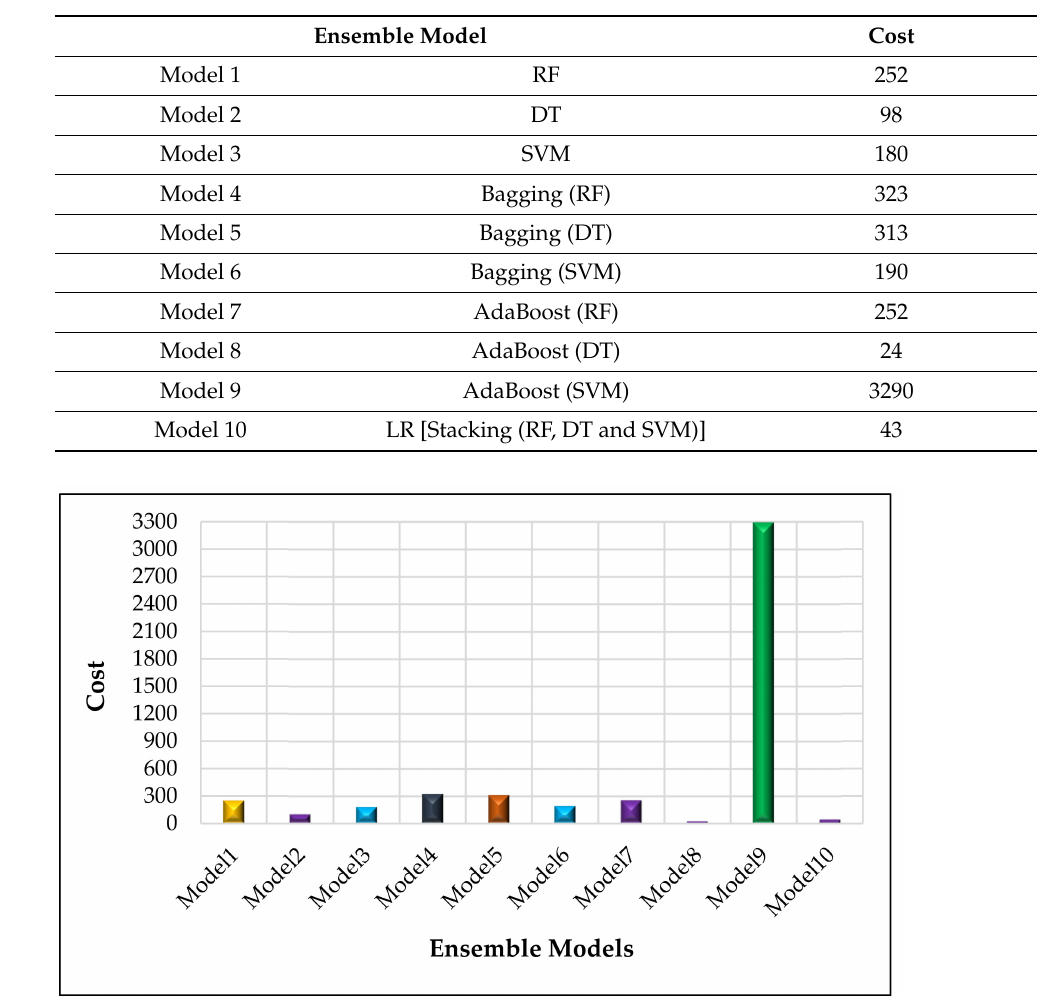
Table 9. Summary of cost results.